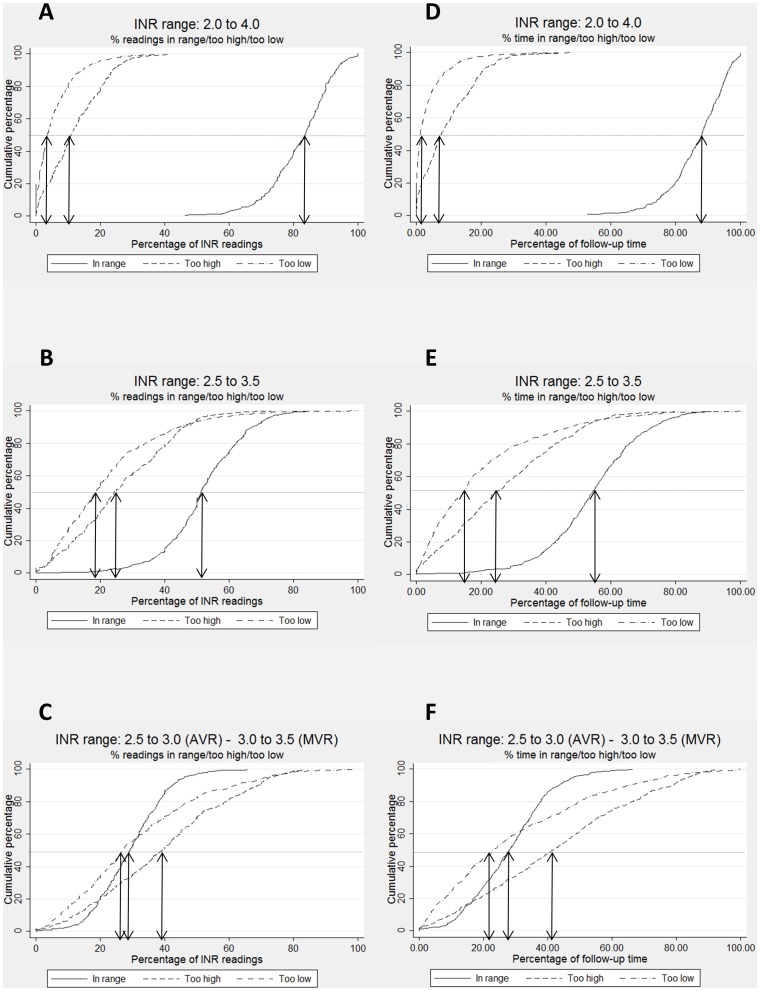
Cumulative percentages of the proportion of readings (panels A, B and C) and follow-up time (panels D, E and F) in range, too high and too low.Results are shown for the three different target INR ranges investigated: I - 2.0 to 4.0 (panels A and D); II - 2.5 to 3.5 (panels B and E); III - 2.5 to 3.0 for the AVR and 3.0 to 3.5 for the MVR groups (panels C and F).